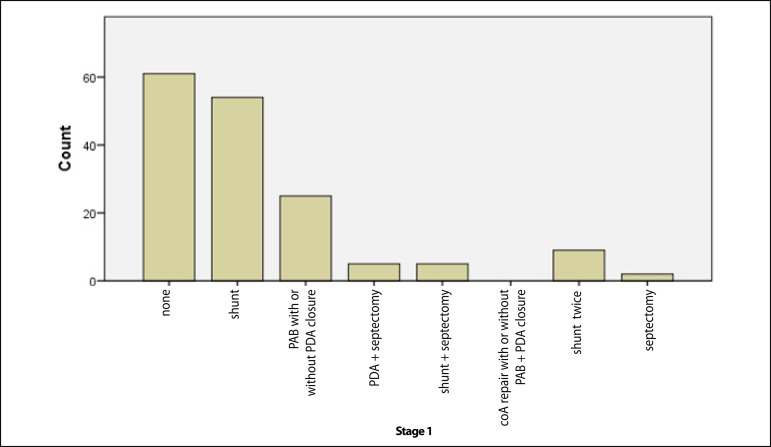
The palliative operations performed as first stage palliation."Count" is expressed as absolute numbers. coA=Coarctation of the
aorta; PAB=pulmonary artery banding; PDA=patent ductus
arteriosus